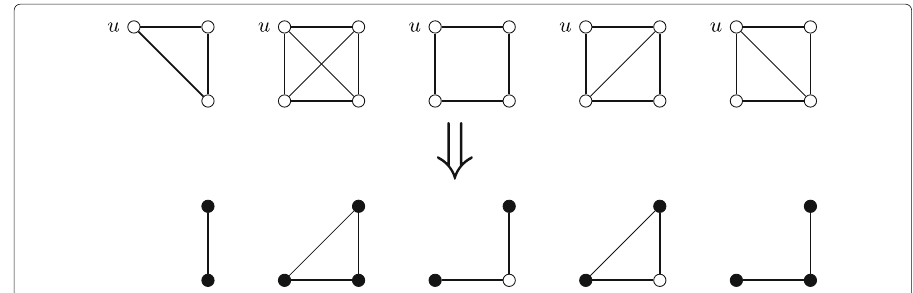
Fig. 5 Top : Configurations that have to be found by our algorithm. Bottom : Resulting patterns to be detected when processing node u . Filled nodes are marked as neighbors of